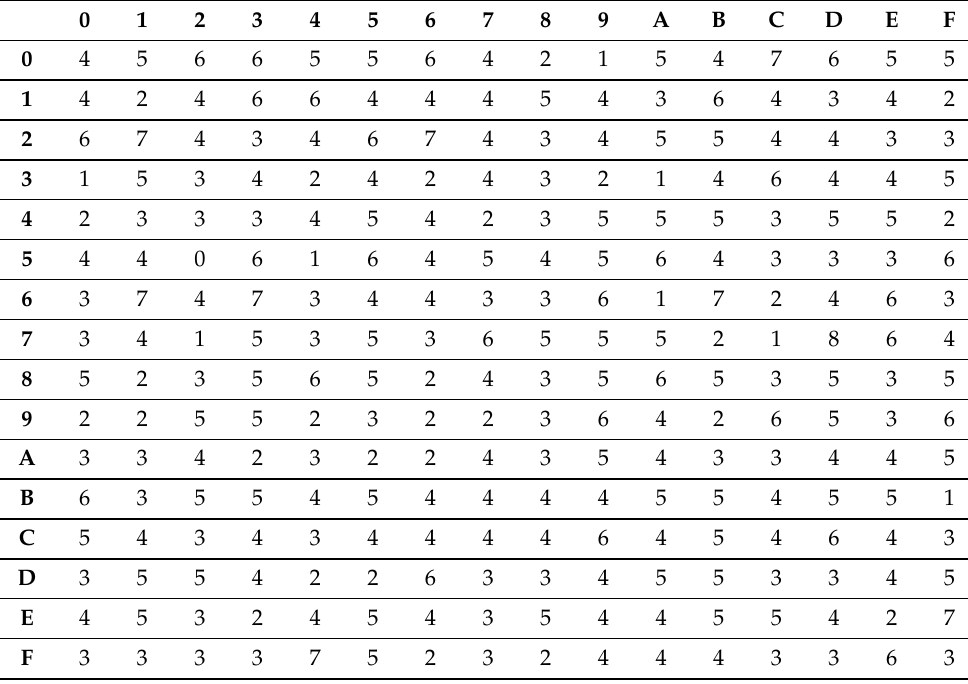
Table A1. Class HW < F AES > of the S-box of the AES